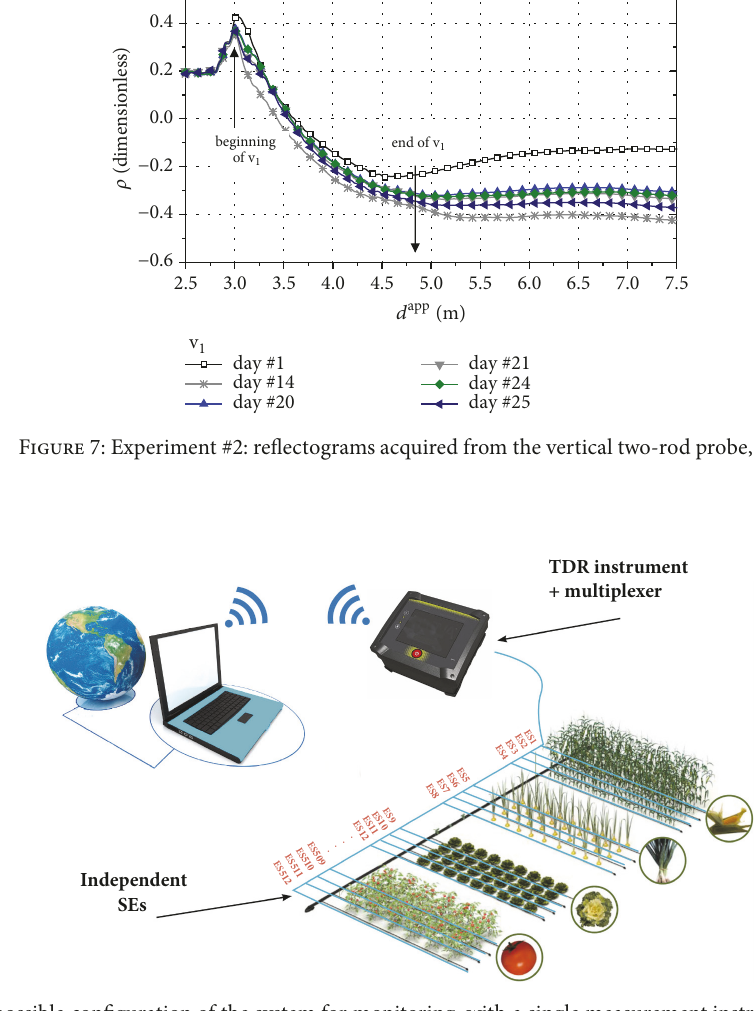
Figure 8: Sketch of the possible configuration of the system for monitoring, with a single measurement instrument, up to 512 independent